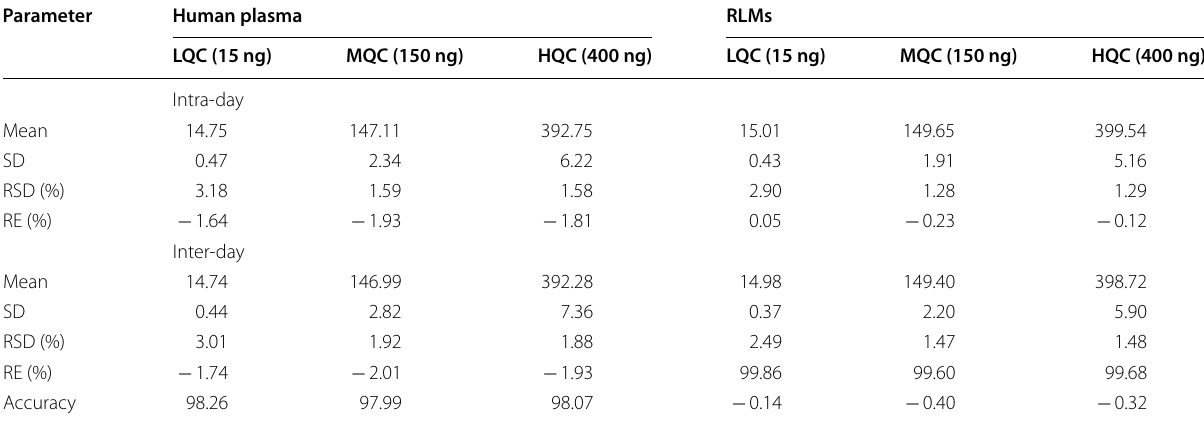
Table 2 Intra- and inter-day precision and accuracy of quality control sample Parameter Human